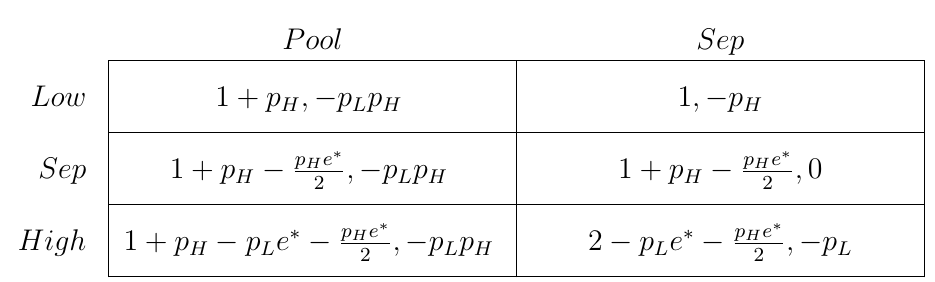
Table 1. The pruned Spence signaling game.